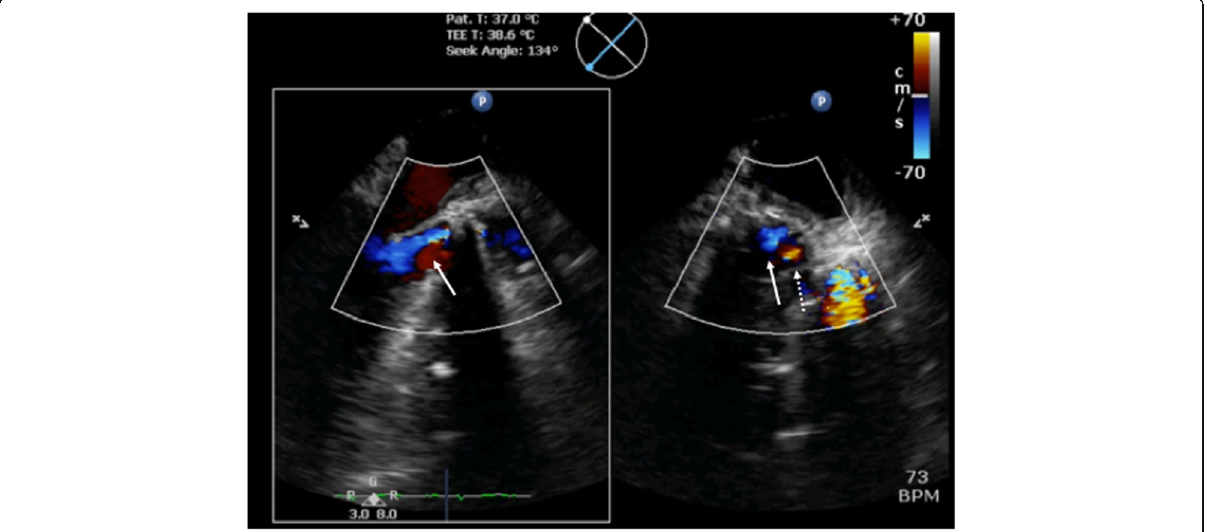
Fig. 2 Using LIVE xPlane, a mid-esophageal aortic valve long-axis transesophageal echocardiography image (left image) and aortic valve short- axis transesophageal echocardiography image (right image) were taken, with the image inverted from right to left. Acceleration flow was recognized in the non-coronary cusp of the intra-sewing ring white arrow indicates aortic regurgitation and white dotted arrow indicates